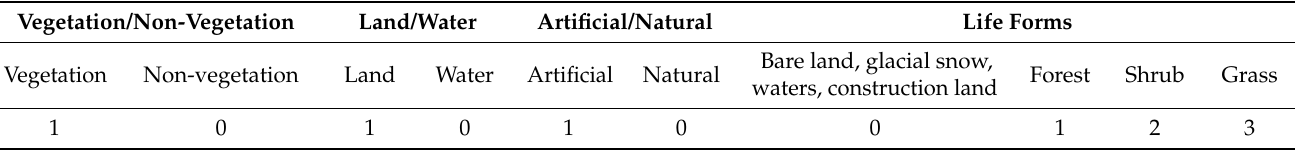
Table 3. The assigned values of the category